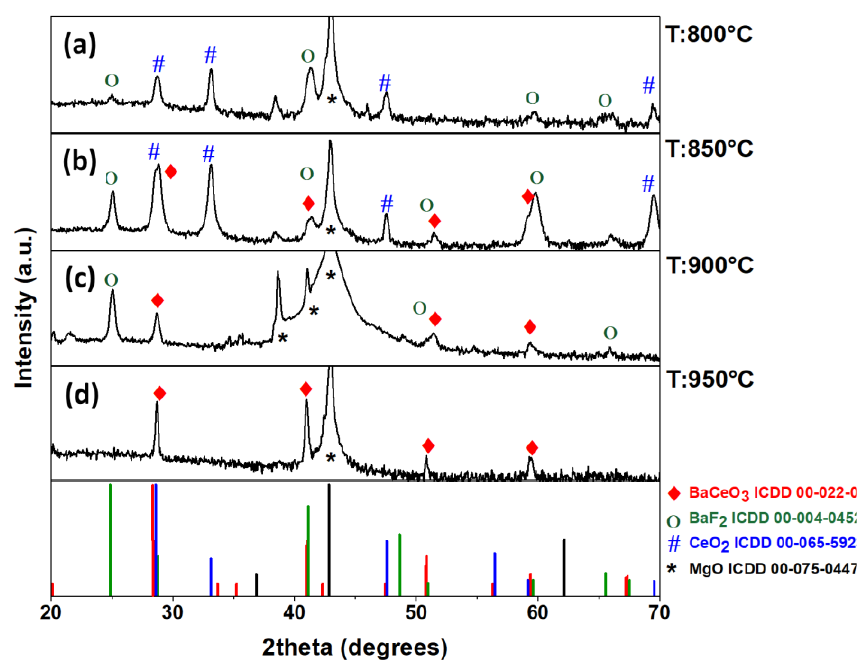
Figure 2. XRD patterns of Ba–Ce-based thin films grown on the MgO (100) substrate at different deposition temperatures: ( a ) 800 °C; ( b ) 850 °C; ( c ) 900 °C; and ( d ) 950 °C.